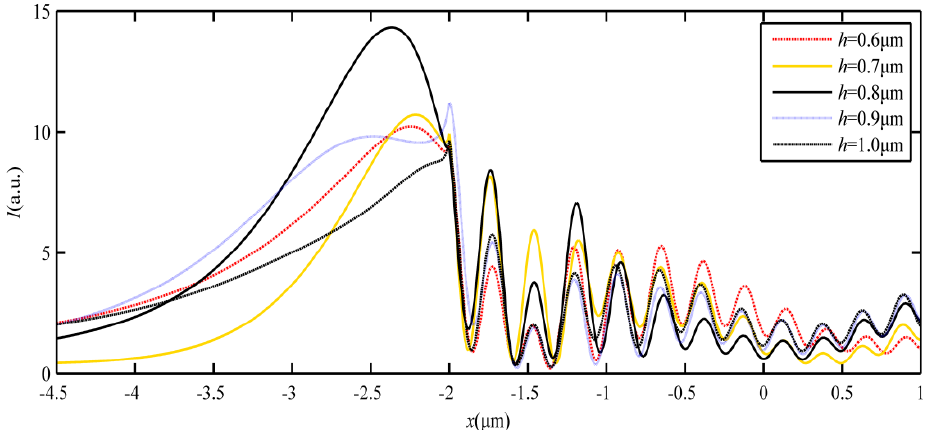
Figure 8. Optical intensity distributions of the SPP − PNJ along the y − axis with different thicknesses h of the dielectric microdisk.